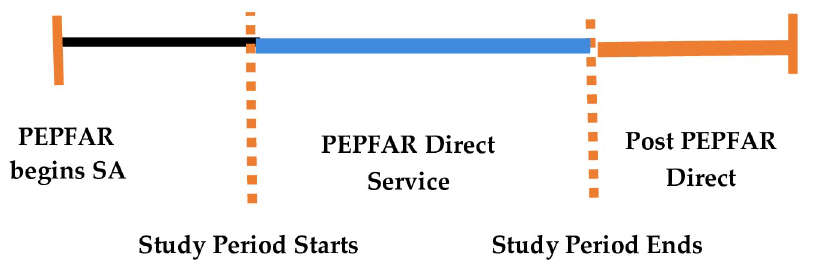
Fig 1. PEPFAR strategy timeline South